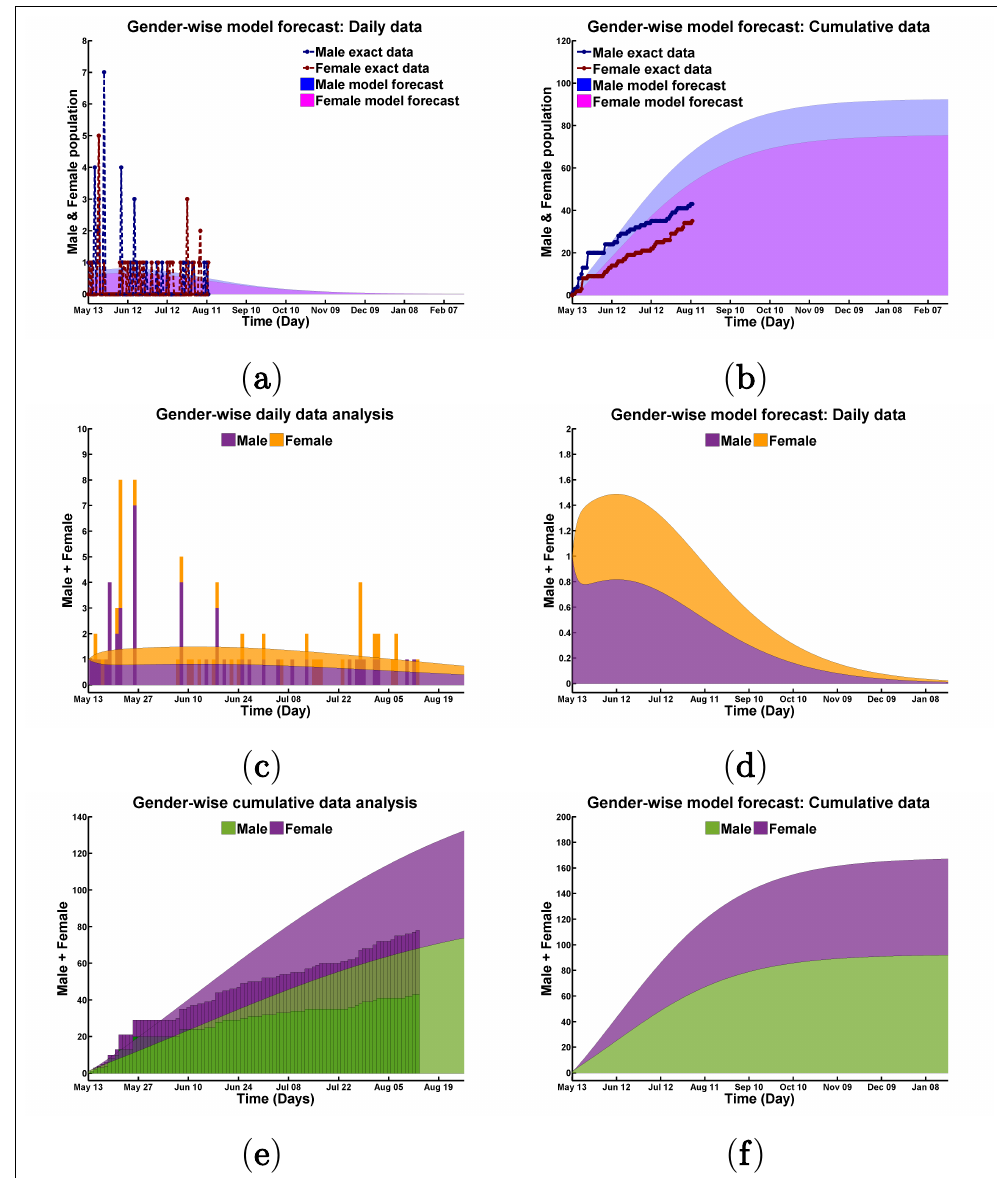
Figure 4: Visual presentation of Gender disparity for model best fitting with real data. Figure 4. Visual presentation of gender disparity for model best fitting with real